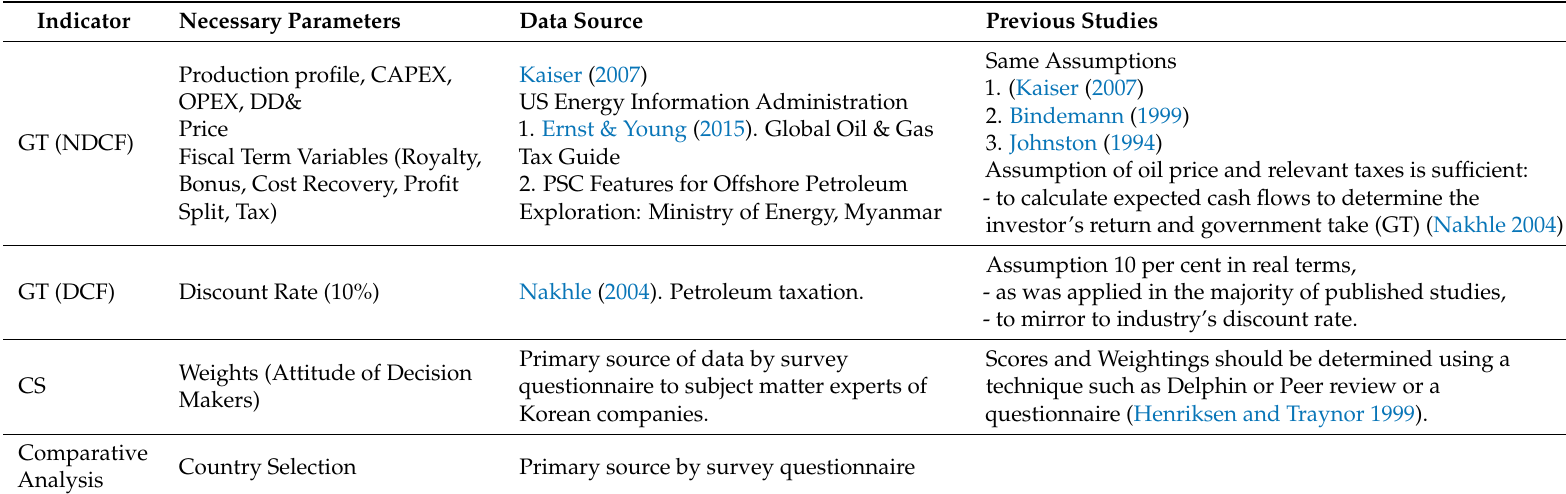
Table 2. Data Sources for each Indicator.